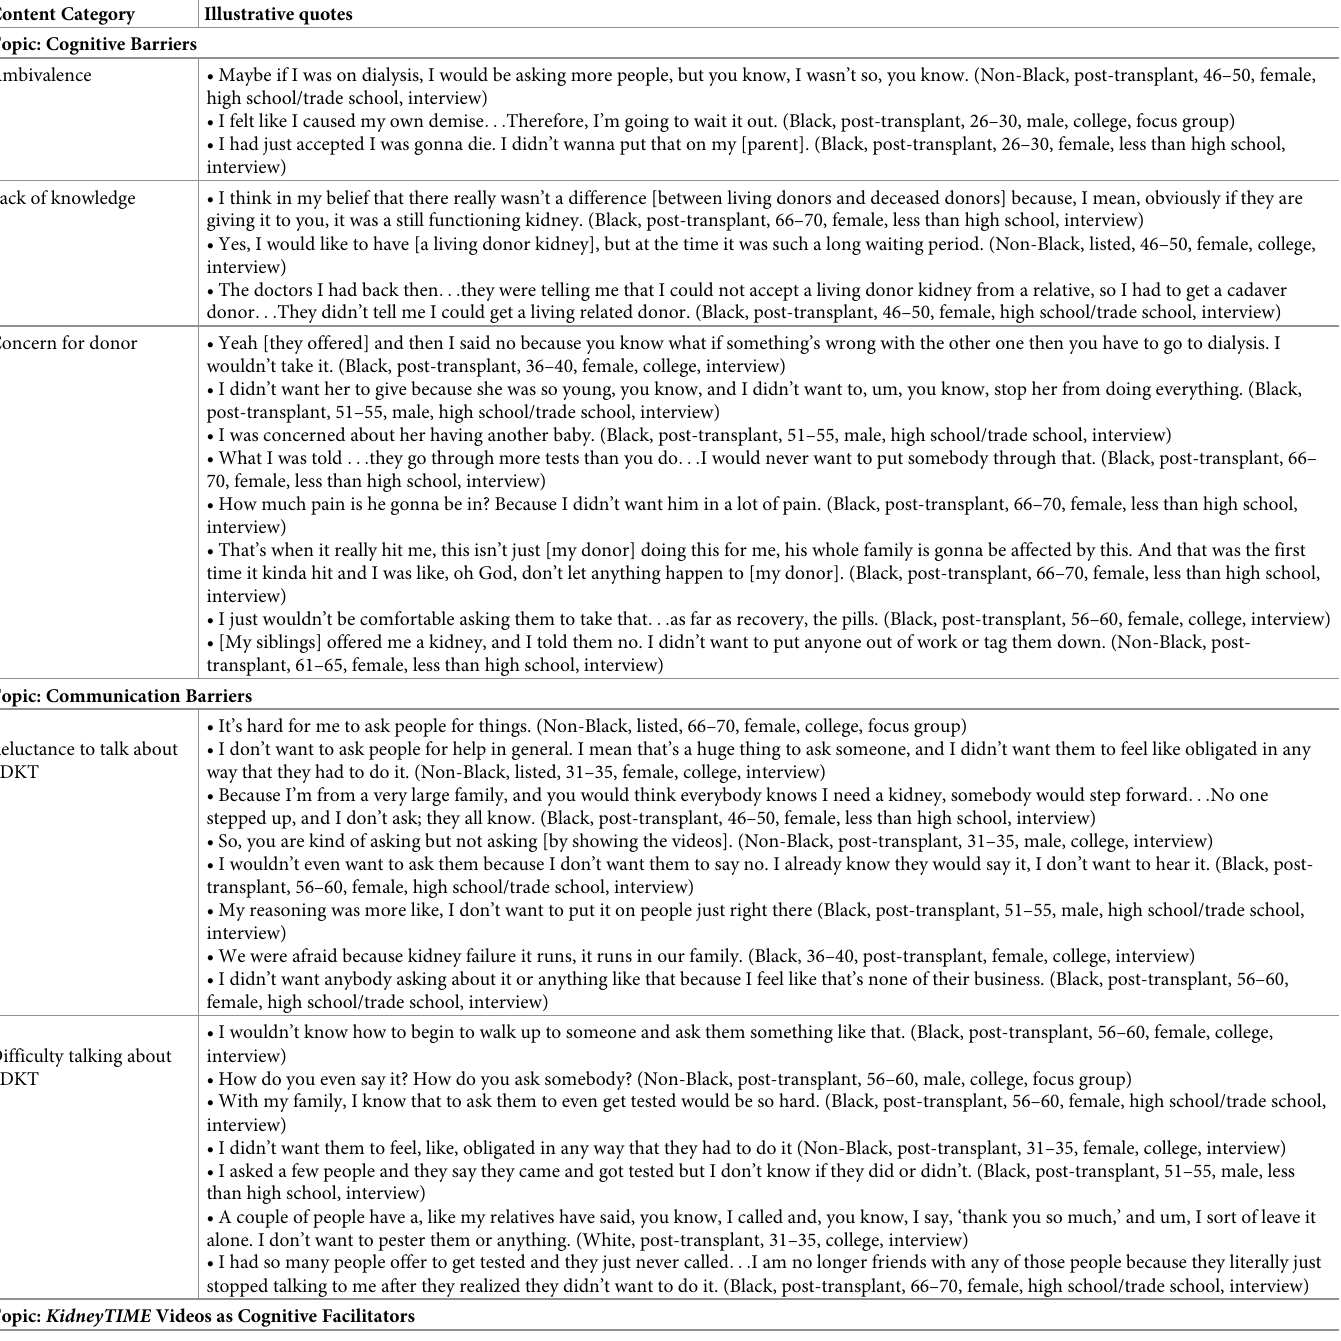
Table 3. Illustrative quotes for content categories within each